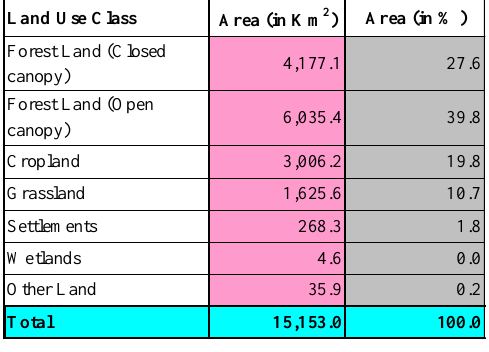
Table 1: Area of Land Use